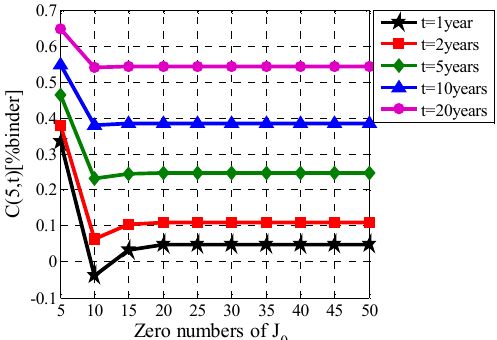
Figure 1. Effects of zero numbers of zero-order Bessel functions J 0 on the accuracy of circular diffusion model.